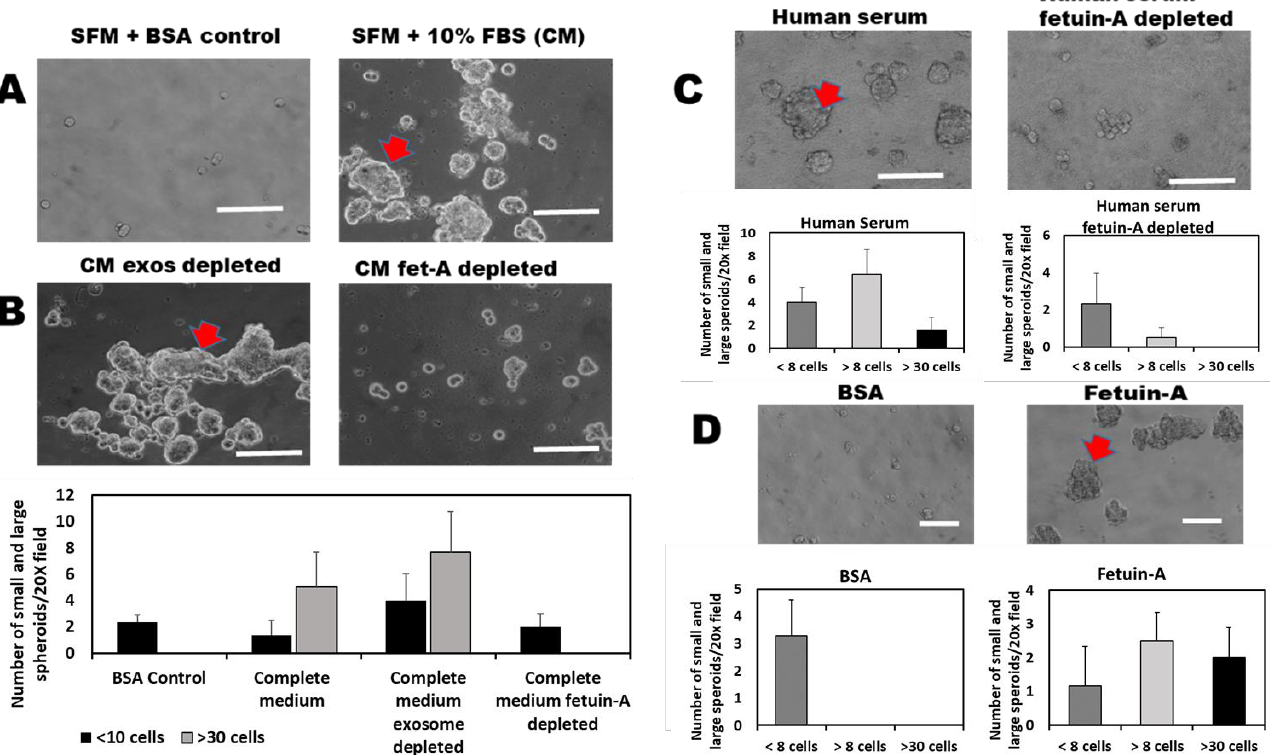
Figure 1. Fetuin-A is the serum factor that promotes 3-D growth of LNCaP cells. In panels ( A , B ), cells were dislodged with Trypsin/EDTA, counted, and then plated as single-cell suspensions in an ultra-low 24-well attachment (1 × 10 4 cells/well) in SFM+BSA (negative control); SFM+10% FBS (CM); CM depleted of exosomes; and CM depleted of fetuin-A. The number of spheroid colonies of different sizes was counted (20 × microscopic field) after 10 days of growth, as depicted. In panel ( C ), single cells (1 × 10 4 cells/well) were plated in SFM+10% adult human serum (Human serum) or SFM+adult human serum depleted of fetuin-A. The number of the different sizes of spheroid colonies in a 20 × field (N = 6) was determined after 10 days of growth. In panel ( D ), single cells again were plated as above in SFM+BSA (negative control) or SFM+purified fetuin-A. The numbers of the different sizes of spheroid colonies in a 20 × field are shown. Scale bars in panels ( A – C ) = 100 µ m; in panel ( D ) =50 µm. The growth assays were repeated 5 times.